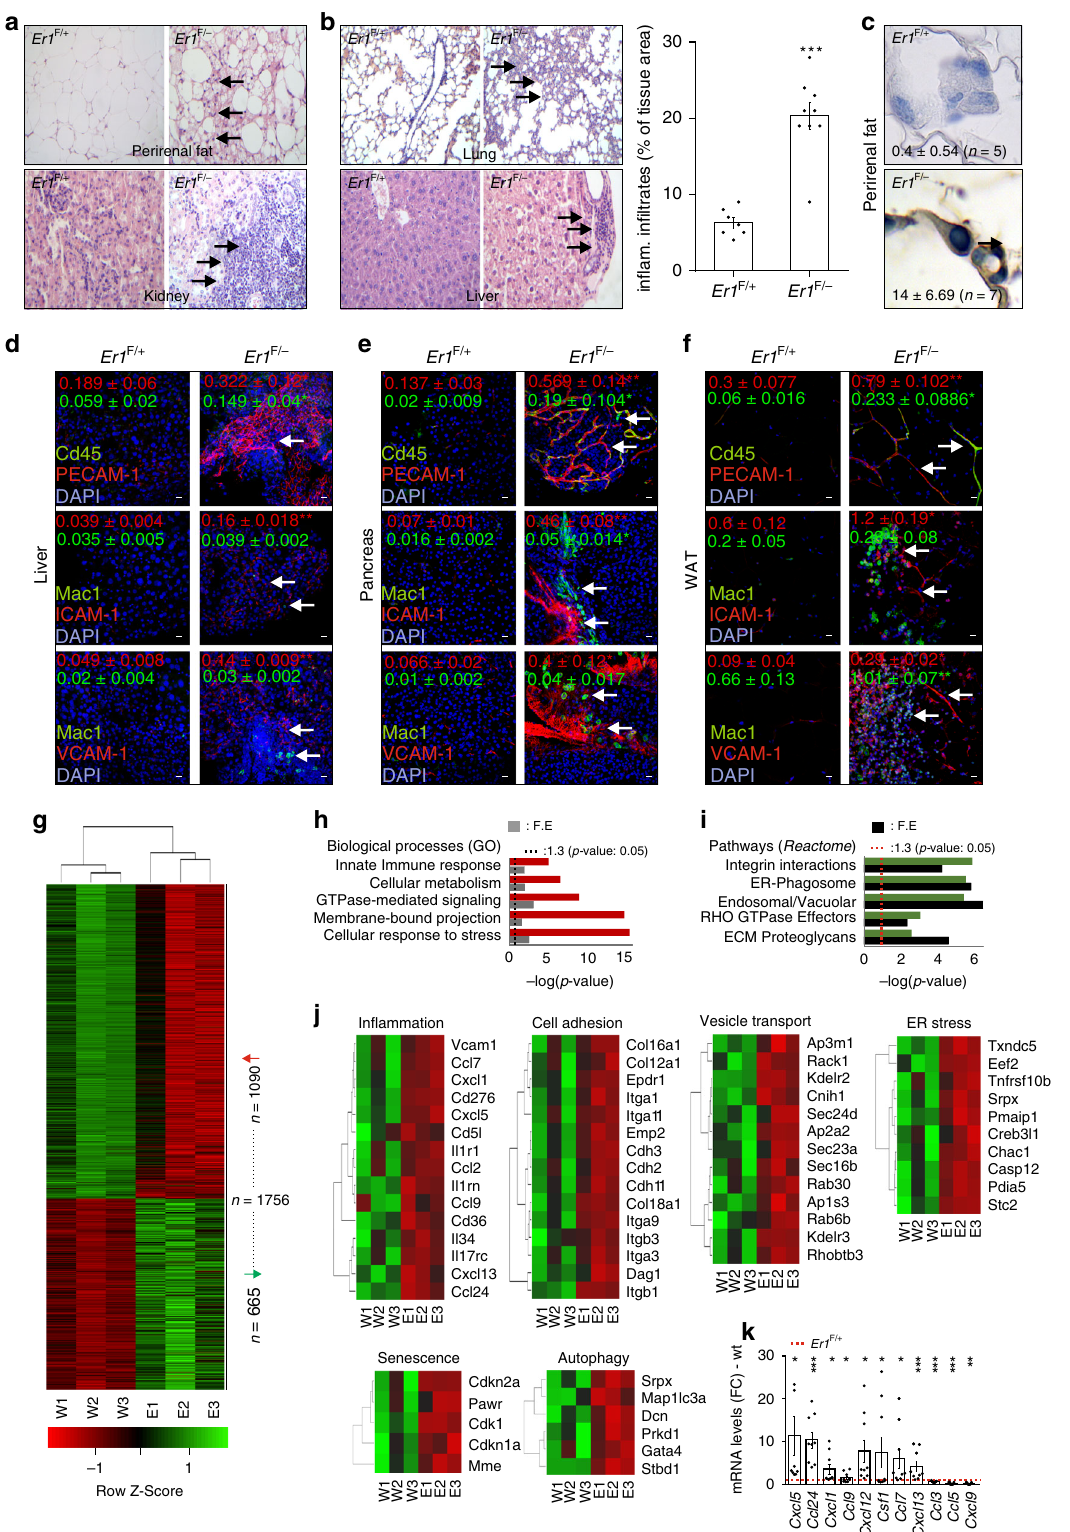
(Supplementary Fig. 7A). Following the exposure of PPCs to Er1 F/ − EVs carrying the GFP-tagged RAB10 and RAC1, we were able to detect both proteins in the cytoplasm of EV-recipient PPCs (Fig. 6b, c). Because several members of the RAB, RAS, and RHO family of small GTPases are known to regulate glucose uptake and are involved in the traf fi cking of glucose transporters